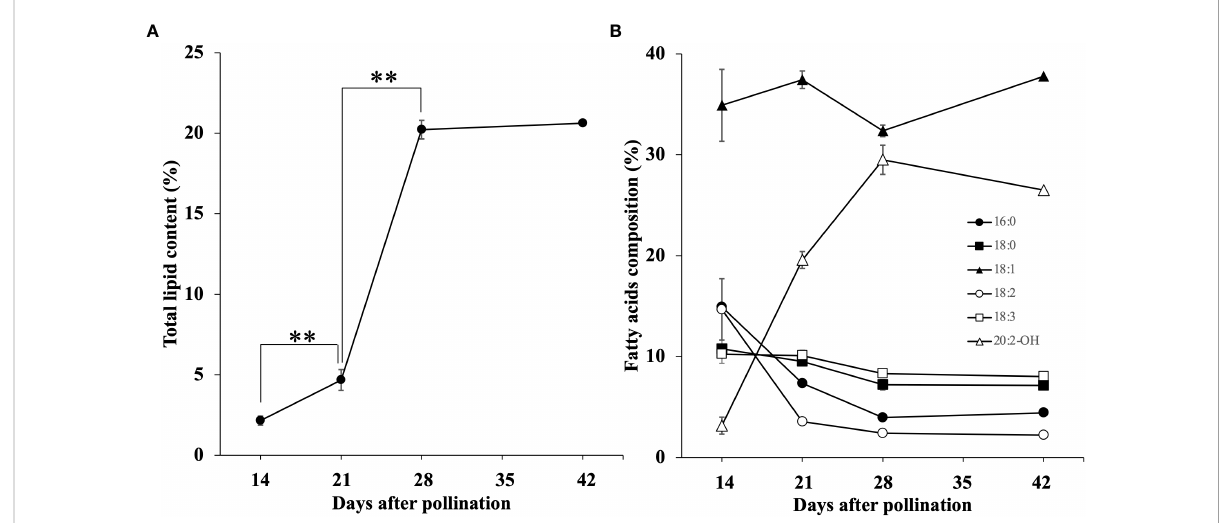
FIGURE 2 Accumulation of total lipids (A) and six major FA composition (B) during seed development. Each data point represents the mean ± SD of triplicate samples. The double asterisks indicated Signi fi cant changes that analyzed by t-test (p <